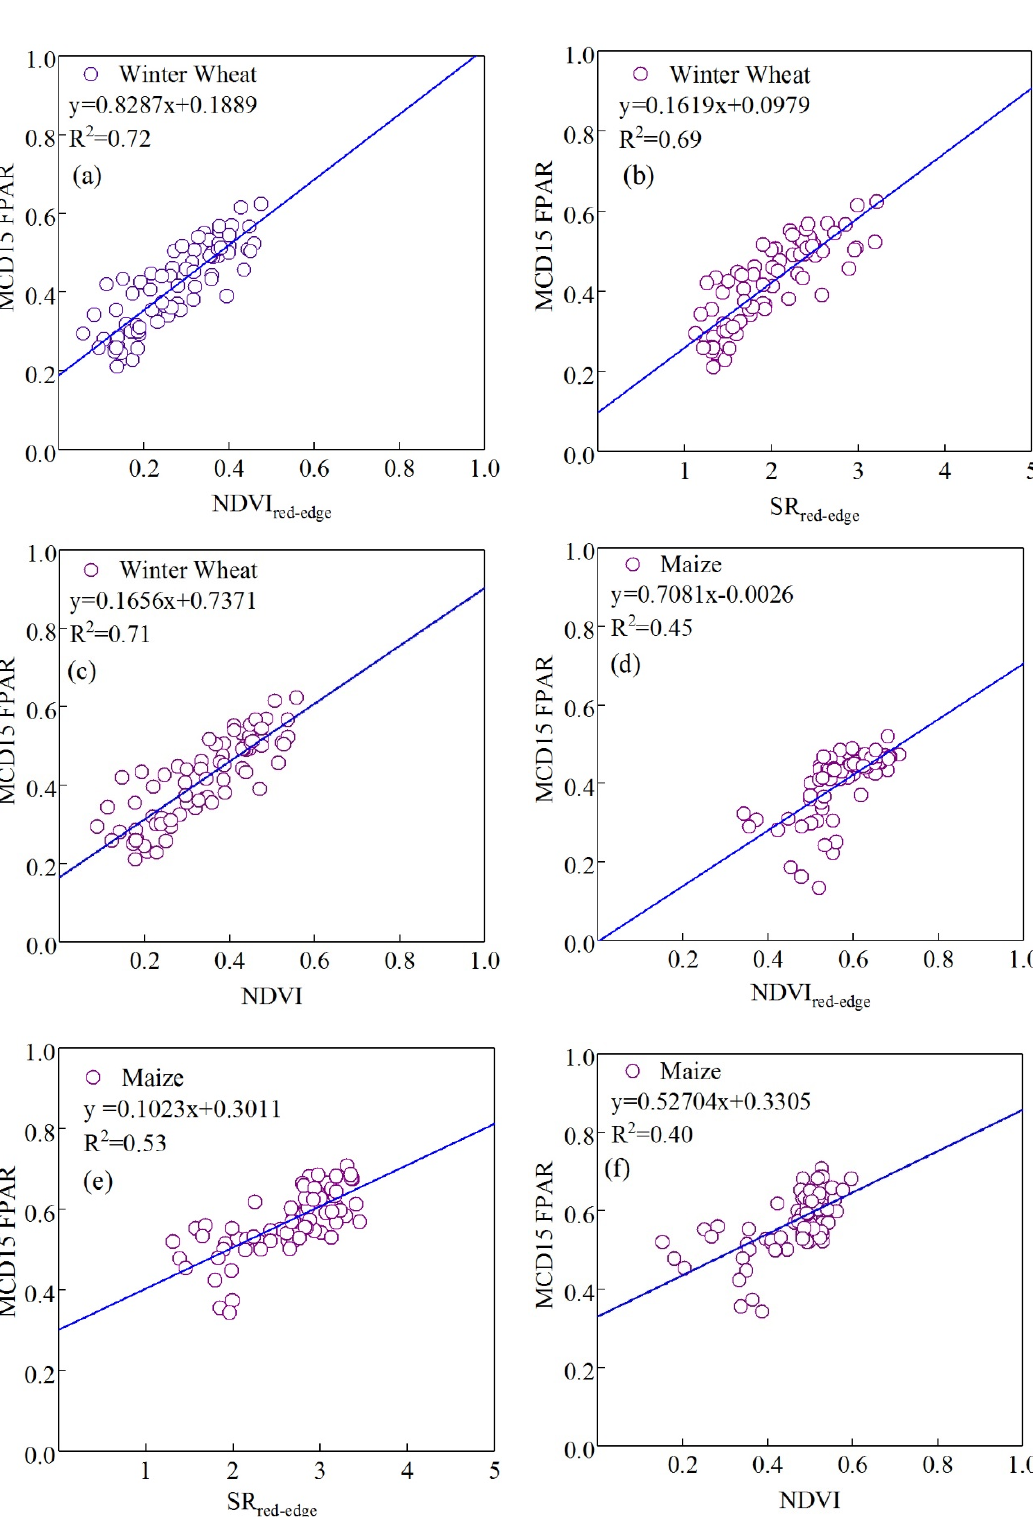
10 of 27 Figure 5. Spectral reflectance curves and variations of crops in red-edge information. ( a ) Spectral curves of winter wheat and maize. ( b ) Variations in the red-edge positions of winter wheat and maize. Figure 5a shows the variations in the spectral reflectance curves and red-edge infor- mation in the main growing seasons of the two crops. In Figure 5b, the rate of changes in summer maize within 705 nm of the red-edge is higher than that of winter wheat, because the photosynthetic efficiency of summer maize (C4 crops) is usually higher than that of winter wheat (C3 crops) [49]. However, the change rates of winter wheat and summer maize in the range of 740 and 783 nm of the red edge are basically the same, which indi- cates that in this interval, the red-edge spectrum is insensitive to the chlorophyll of the two crops. Previous research has also shown that the positions of the crops at a red-edge of 705 nm are more suitable for the inversion of the bio-physiological parameters [17,50]. Therefore, we used the red-edge vegetation indices NDVI red-edge and SR red-edge to fit the MCD15A3H LAI/FPAR products in the corresponding crop growing season, and the inversion results are shown in the following figures. Figure 6 shows the regression accuracy of the NDVI-related vegetation indices in the